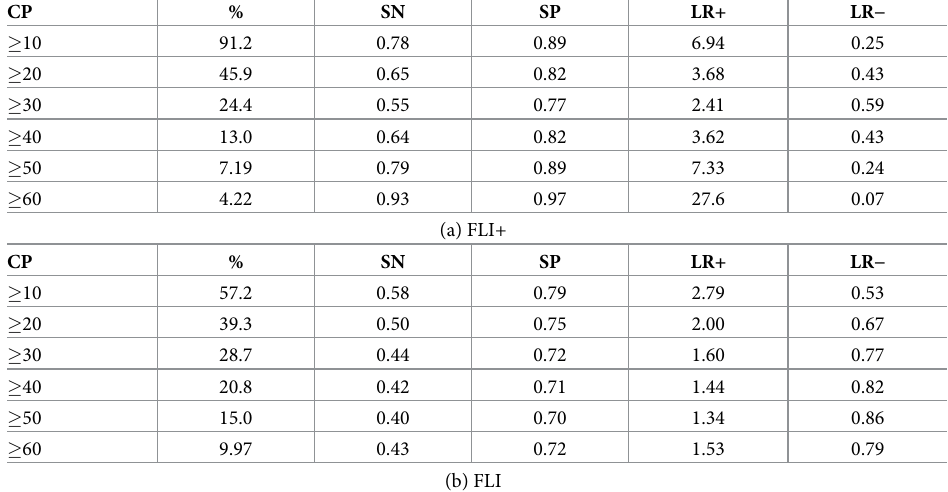
(b) FLI Fatty liver index (FLI)+ (a) and FLI (b) cut-point table by five-unit intervals. Abbreviations: CP = cut-point; % = proportion of patients with an FLI+ and FLI cut-point; SN = sensitivity; SP = specificity; LR+ = positive likelihood ratio; LR − = negative likelihood